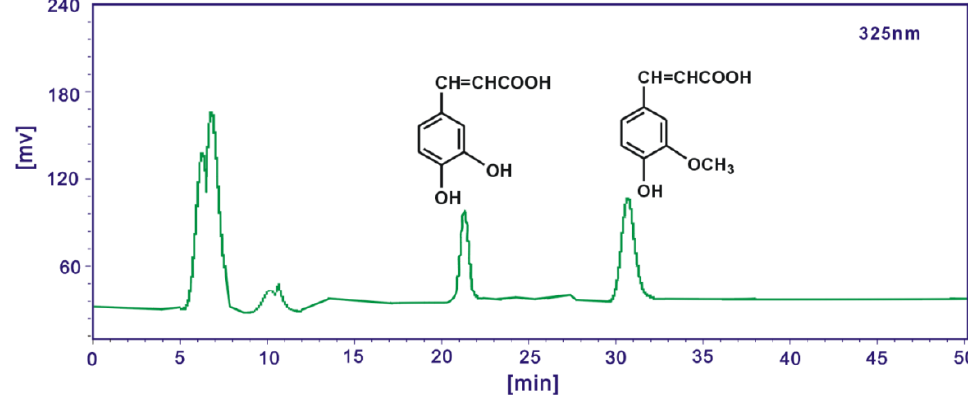
Figure 4. A typical HPLC profile of caffeic acid and ferulic acid in ethyl acetate extract of Rhizoma Atractylodes macrocephala . Syltech P510 system (Los Angeles, CA, USA), Dikma Diamonsil C (250 mm × 4.6 mm, 5 μm) column, methanol/acetonitrile/5% acetate 18 acid (24:6:70), 0.5 mL/min flow rate, 10 μL injection, 325 nm